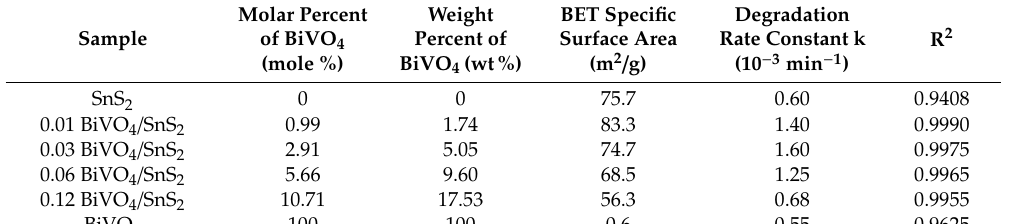
Figure 2. FE-SEM micrographs of ( a ) SnS 2 , ( b ) magnified image of SnS 2 , ( c ) BiVO 4 , and ( d ) 0.03 BiVO 4 /SnS 2 with schematic illustration. Figure 3. EDS elemental mapping of Sn, S, Bi, V, and O elements in 0.03 BiVO 4 /SnS 2 . Table 1. Comparison of molar/weight percent BiVO 4 , specific surface area, and pseudo-first-order-kinetic degradation constant, for SnS 2 , BiVO 4 , and BiVO 4 /SnS 2 composites with various BiVO 4 -to-SnS 2 ratios.